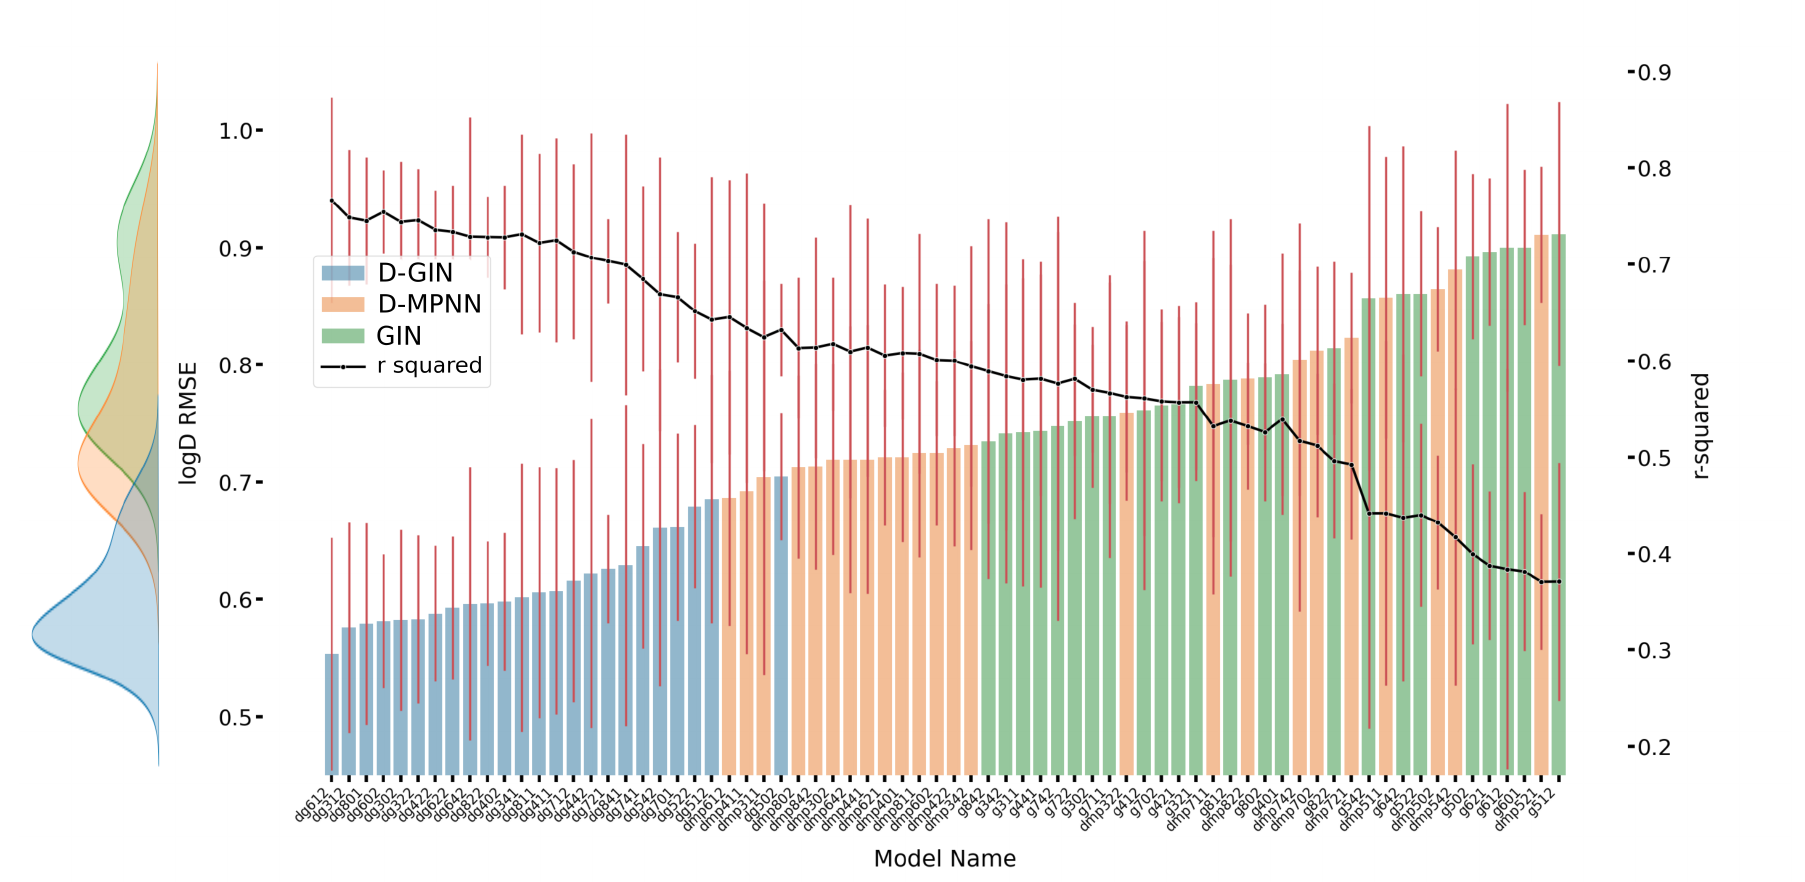
Figure A1. The first y-axis specifies the logD RMSE and the secondary x-axis the corresponding r 2 values for each GNN model. The D-GIN is colored blue, the D-MPNN orange and the GIN green. Each of the boxes represents one different model run. The kernel density of each model is shown on the very left side. The red lines correspond to the 95% confidence intervals. The model names are a combination of model type (D-GIN, GIN, D-MPNN), training approach and featurization type-a detailed description of each model name can be found in Tables A8–A19 in the Appendix